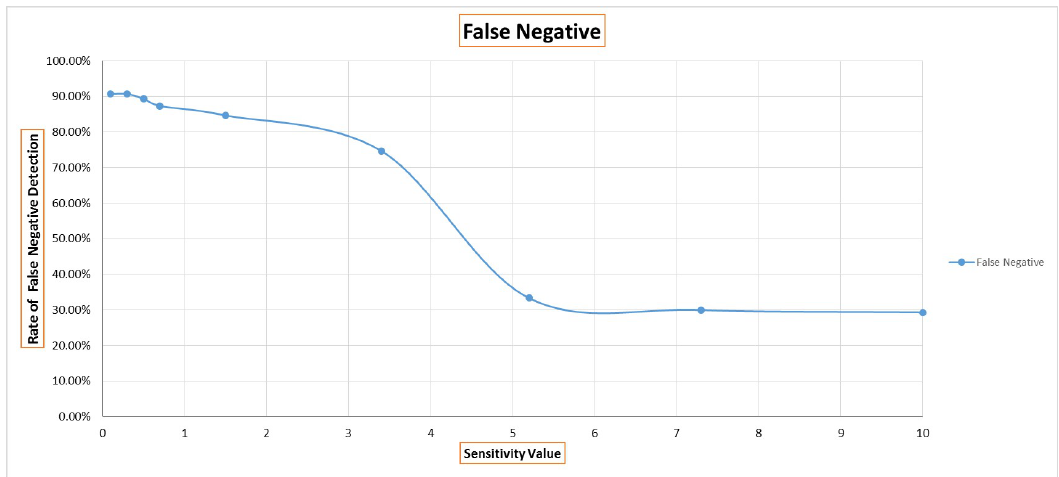
Figure 11. Overall false negative rate of google image database (SAFE OFF) with different sensitivity values.